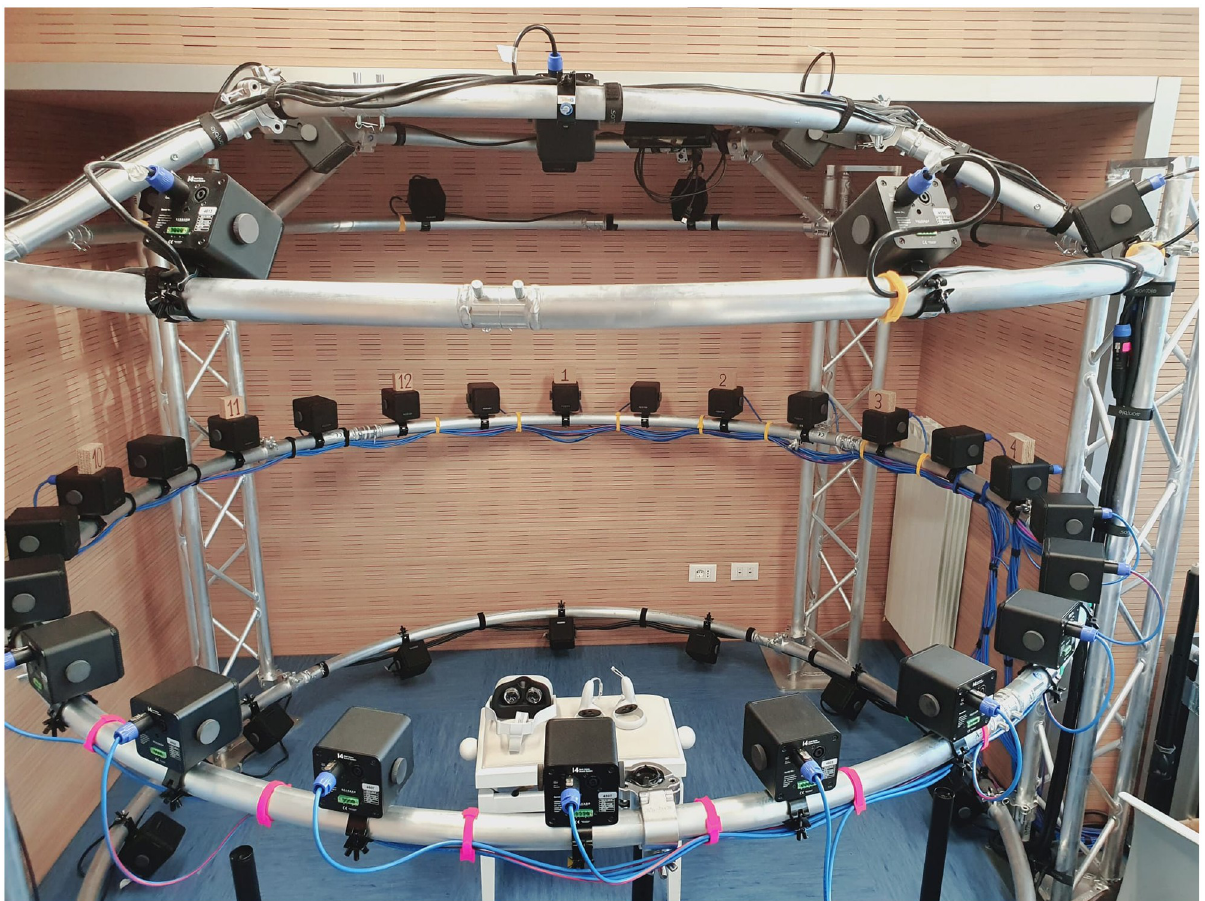
Fig 1. “La stanza di Matilde”: Institute for Maternal and Child Health IRCCS “Burlo Garofolo”s multifunctional audiological assessment space.